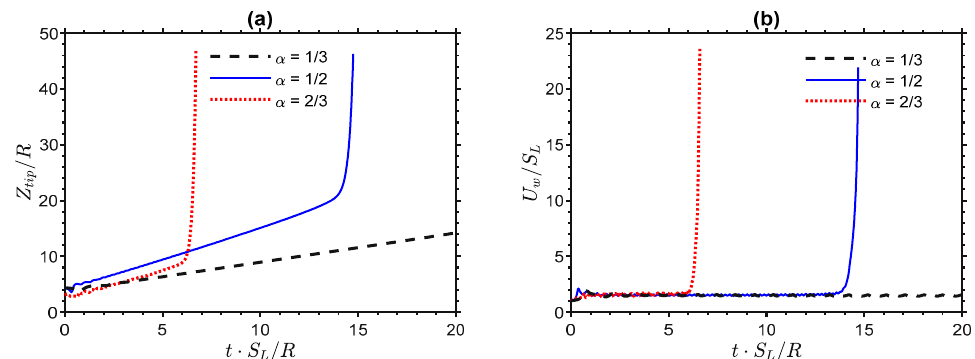
Figure 6. The scaled flame tip position Z tip / R ( a ) and the scaled burning velocity U w / S L ( b ) versus the scaled time τ = tS L / R for the Θ = 8 flame in the channels of half-width R = 24 L f with various blockage ratios α = 1/3, 1/2, 2/3.